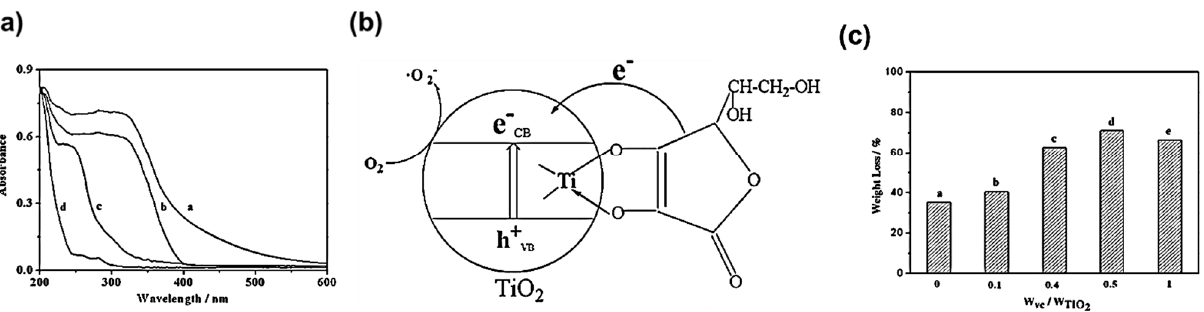
Figure 11. Photodegradation of PVC-VC-TiO 2 film. ( a ) UV–VIS absorption spectra of different films before irradiation: PVC–VC–TiO 2 film with 2 wt% TiO 2 and 1 wt% VC (curve A), PVC–TiO 2 film with 2 wt% TiO 2 (curve B), PVC–VC film with 2 wt% VC (curve C), and pure PVC film (curve D). ( b ) The proposed mechanism of photocatalysis process for VC modified TiO 2 . ( c ) The weight loss rate at different mass ratios of VC to TiO 2 in PVC-VC-TiO 2 film; [61] reprinted from [61] with permission from Elsevier.